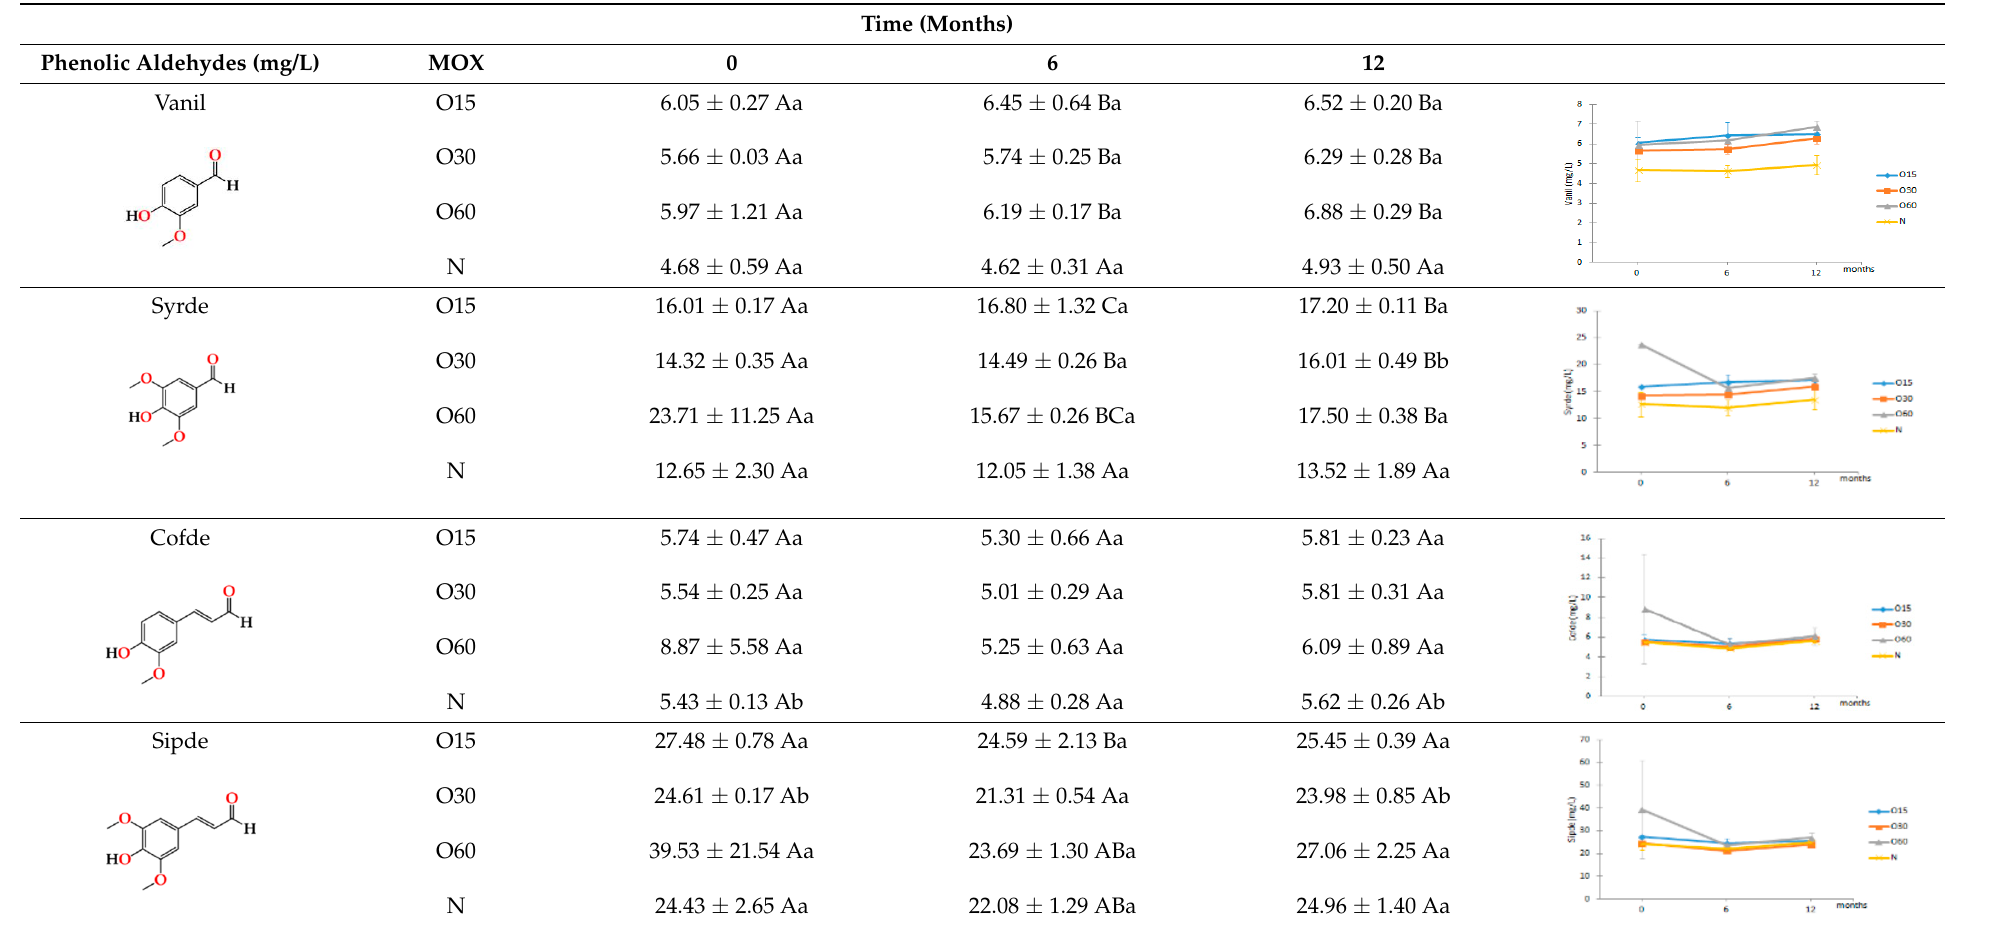
Table 2. Evolution of the phenolic aldehydes from aged WS in each storage time (0, 6, 12 months) according to ageing modalities (O15, O30, O60 and N).